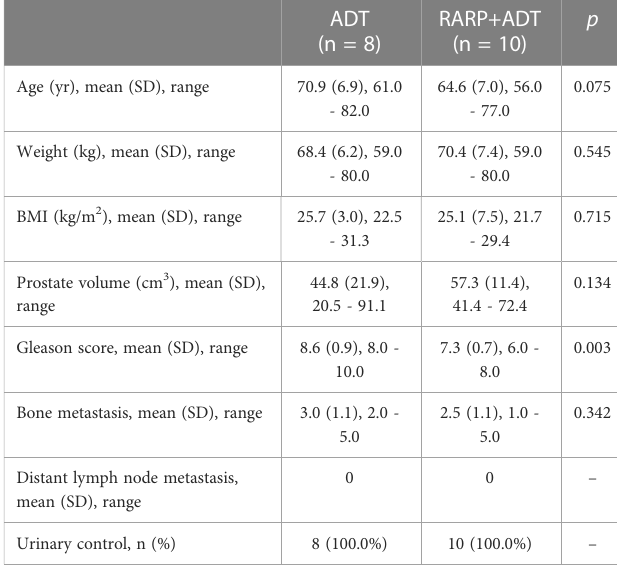
TABLE 1 Demographic characteristics, prostate volume and tumor